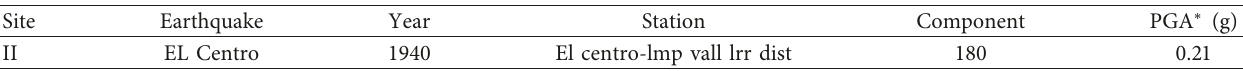
Table 5: Selected ground motion records.